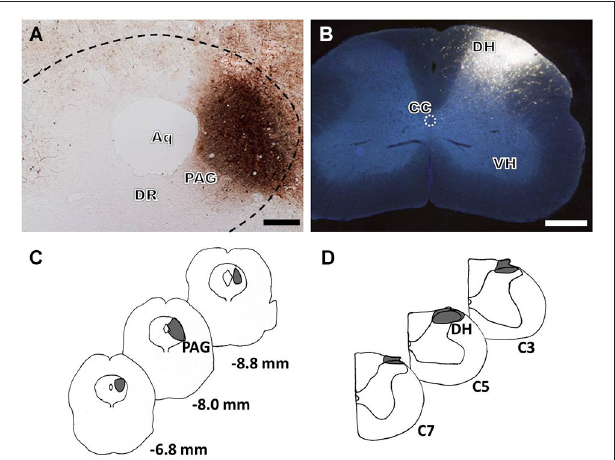
FIGURE 1 | Bright-field and fluorescence photomicrographs showing the BDA injection site in the LPAG (A, scale bar = 100 µ m) and the FG injection site in the cervical SDH (B, scale bar = 200 µ m) . Camera lucida drawings show the rostro-caudal extent of the BDA (C) and FG (D) injection sites at different levels, indicated by the blackened areas on the drawings. The numbers (C) correspond to the distance in millimeters (mm) posterior to bregma in the brain, and C3, C5, and C7 (D) indicate the corresponding segments of the cervical spinal cord. Aq: aqueduct; DR: dorsal raphe nucleus; DH: dorsal horn; VH: ventral horn; CC: central